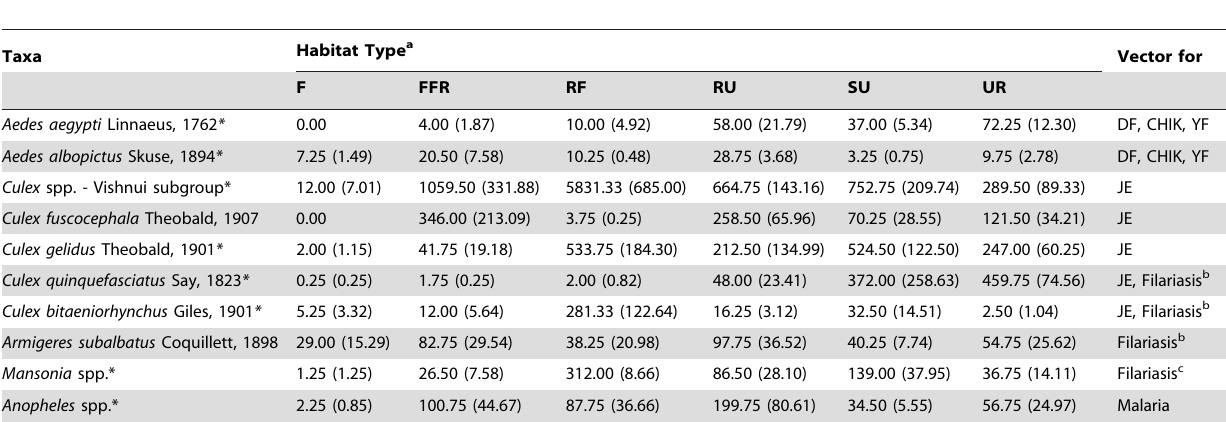
Table 3. Average abundance of vector species ( 6 SE) found in the forest (F), fragmented forest (FFR), rice field (RF), rural (RU), suburban (SU), and urban (UR) habitat in Nakhon Nayok Province, Thailand in